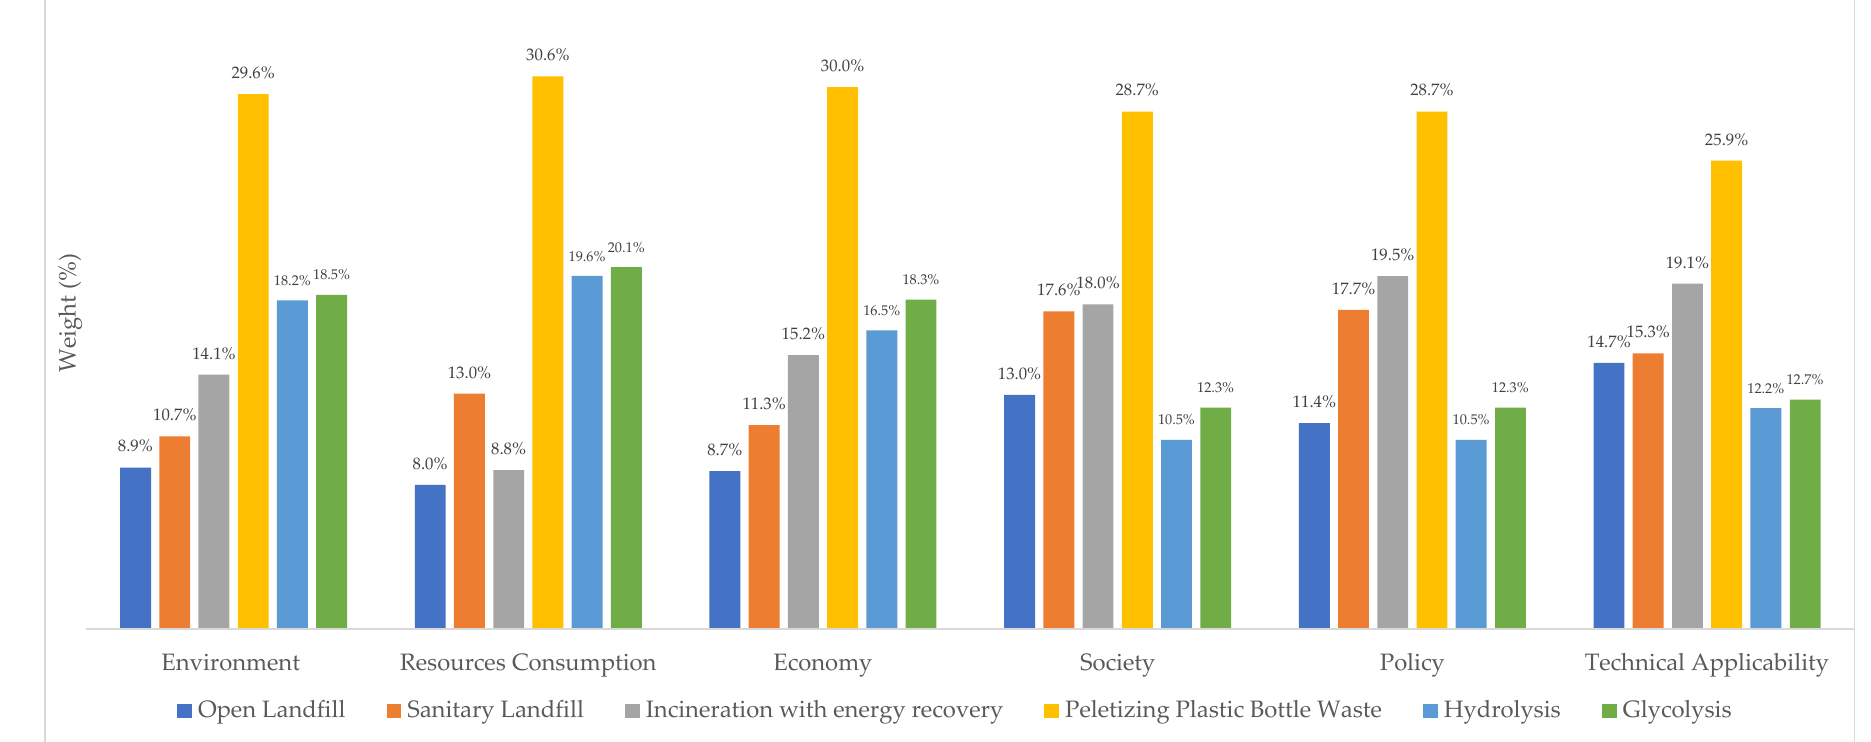
Figure 6. Alternatives’ weights in criteria (%).